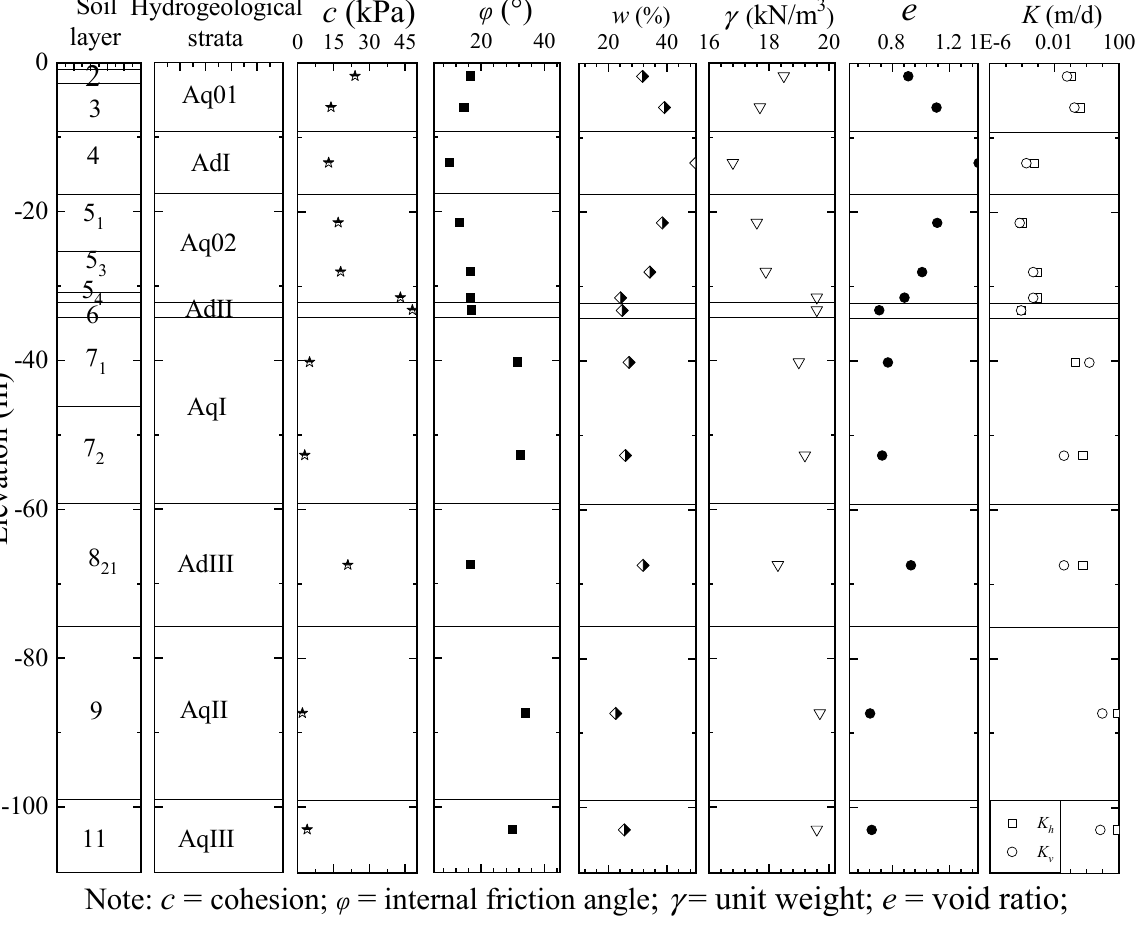
Figure 2. Soil profile and properties of soil layers.